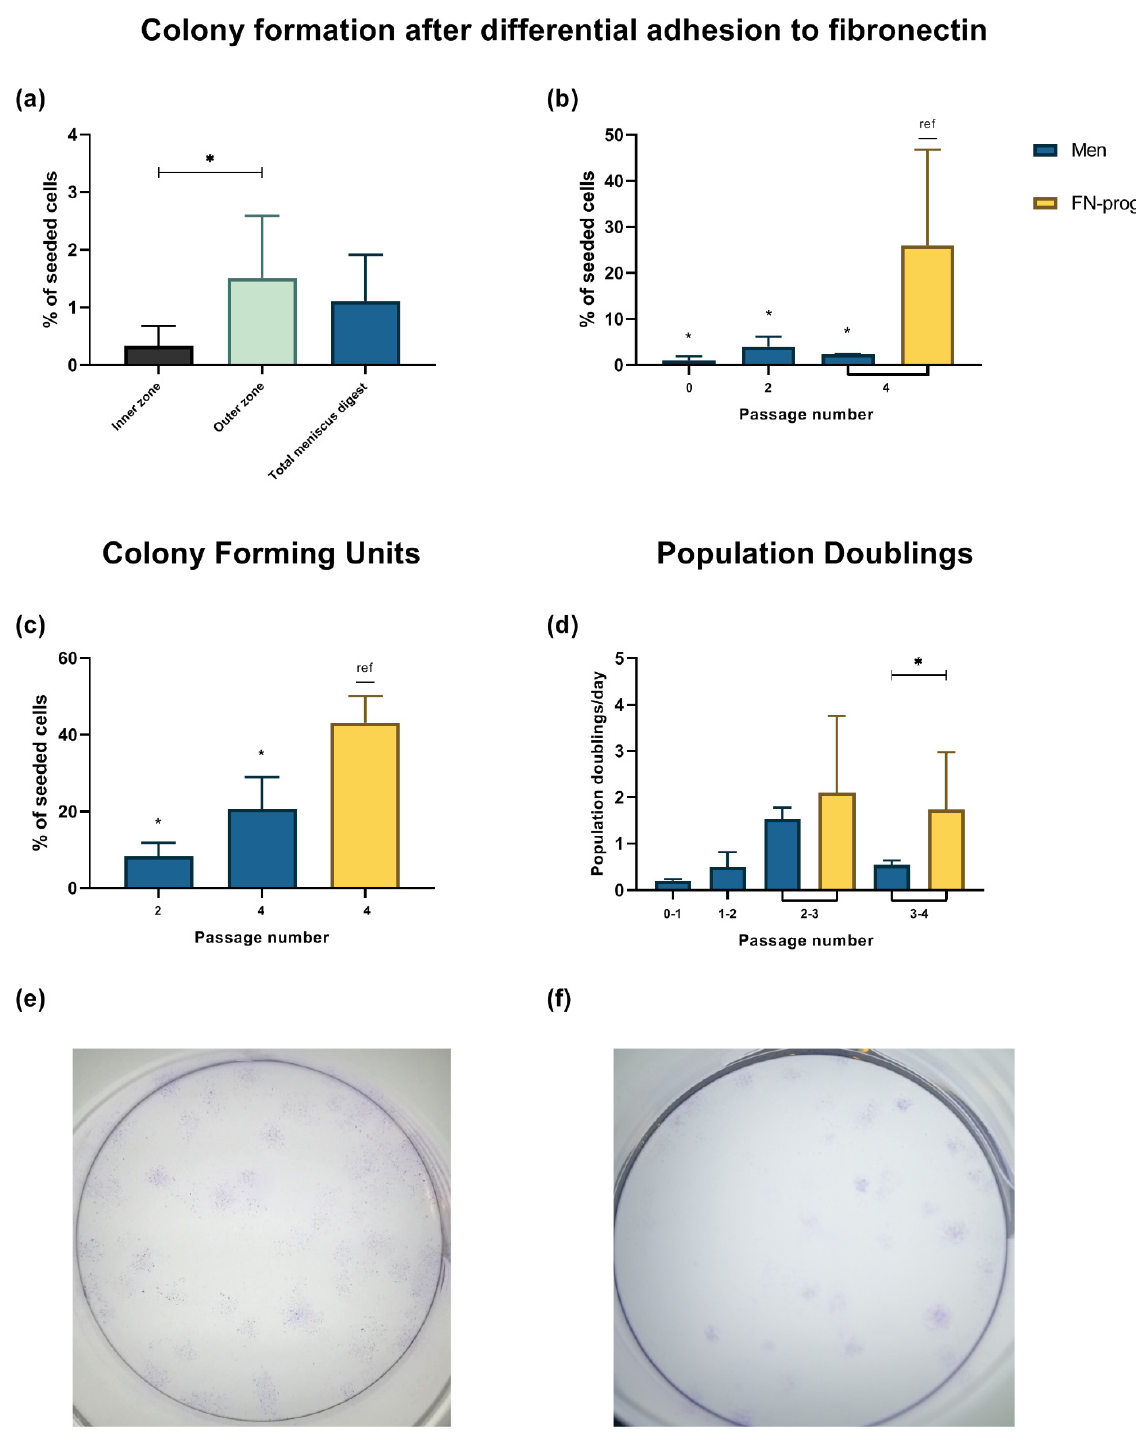
Figure 1. Colony formation after fibronectin selection of ( a ) inner zone, outer zone and total meniscus digest at passage 0 and ( b ) different passages of the total meniscus population (Men) and fibronectin selected cells (FN-prog), comparison between different passage numbers of the total meniscus population (Men) and fibronectin selected cells (FN-prog) in ( c ) colony forming units on culture dishes without fibronectin coating and ( d ) population doublings per day. Representative pictures of colonies formed after seeding ( e ) Men at 11 cells/cm 2 or ( f ) FN-prog at 6 cells/cm 2 both at passage 4, stained with crystal violet blue. * p < 0.05; ref, reference category.